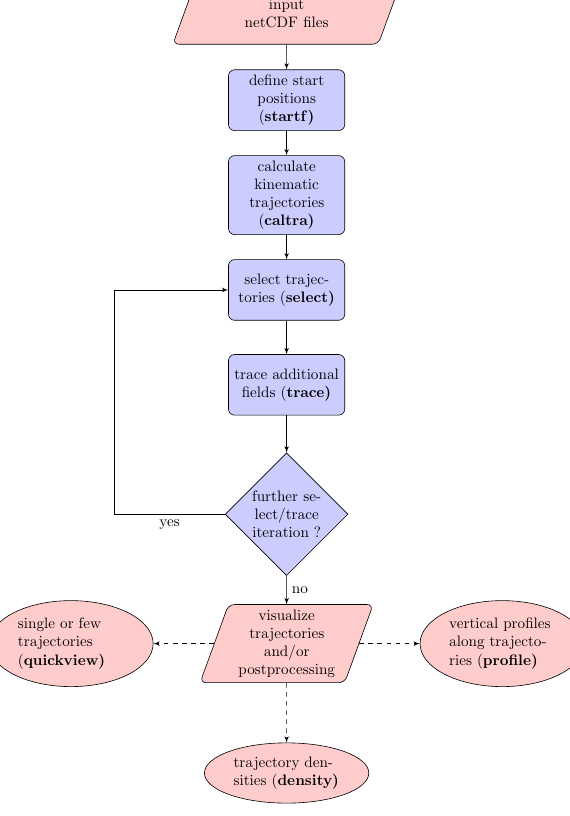
Figure 2. Flowchart showing the typical steps in a LAGRANTO trajectory calculation (LAGRANTO tools are written in bold). The input files include the 3-D wind fields at several time steps. Starting positions (longitude, latitude, pressure) are defined with startf . Then trajectories are calculated with caltra , and possibly subsamples of trajectories are selected with select . Along these trajectories addi- tional fields are traced with trace , which might then ask for further select/trace iterations. The resulting trajectories can be further ana- lyzed or visualized: quickview shows individual trajectories; density calculates trajectory densities on a geographical grid, and profile al- lows one to study the air columns the trajectory is passing through. For further details, see text (Sect.